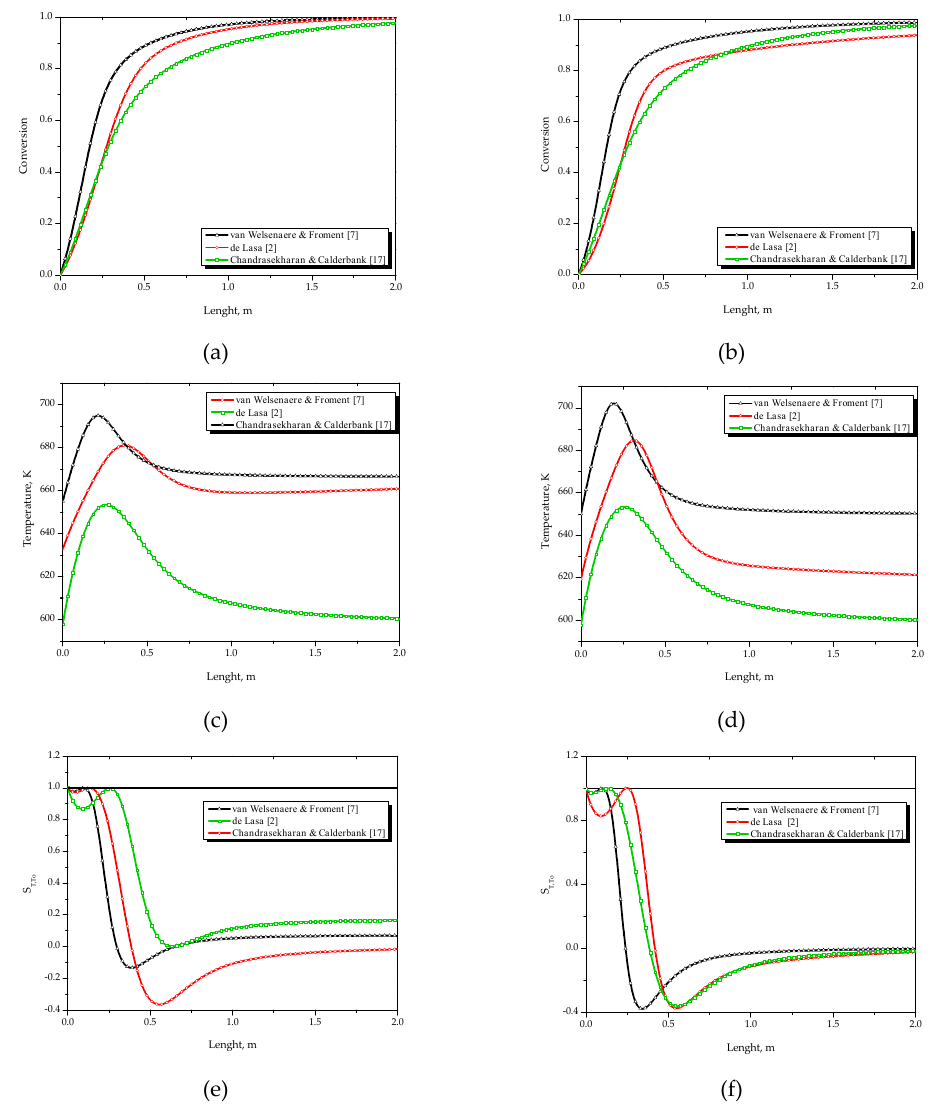
Figure 4. Effect of cooling flow pattern and kinetic model on: conversion, reaction temperature and temperature sensitivity index profiles. Co-current flow: ( a , c , e ) and countercurrent flow ( b , d , f ). P Ao = 0.9322 kPa, other simulation conditions from Table 2.